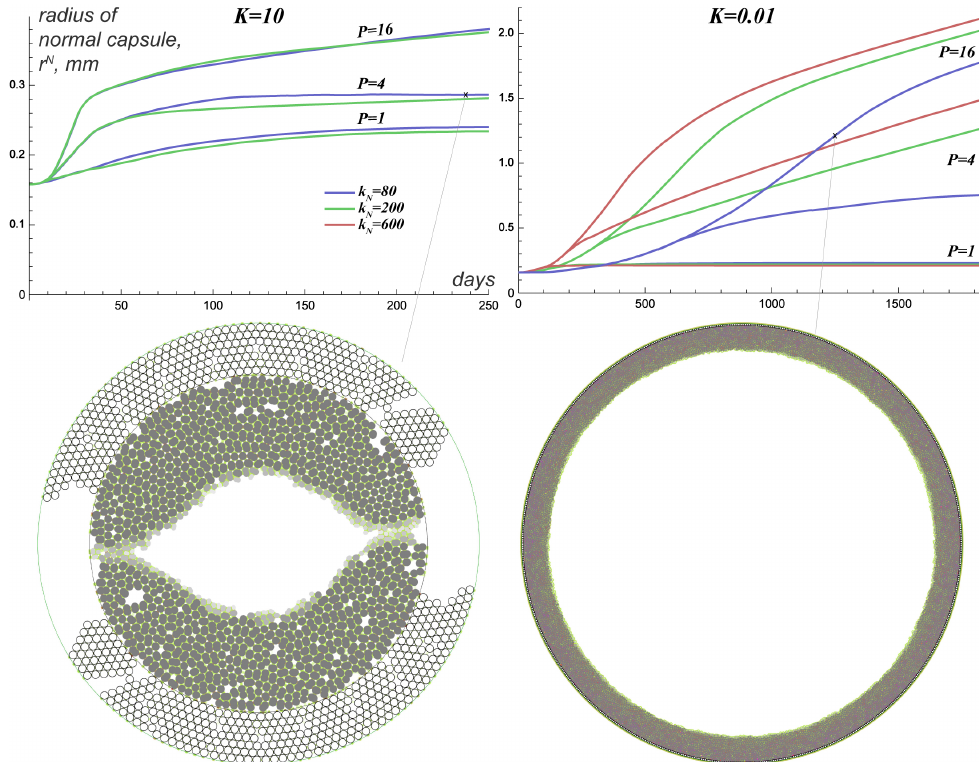
Figure 8. Top row: Dynamics of the radius of normal capsule r N during encapsulated tumor growth in the tissue under variation of normal cell stress function coefficient k N , tissue conductivity K , and coefficient of nutrient inflow P . Tumor cell stress function coefficient k T = 80, and other parameter values are from the basic set (see Tables 1 and 2). Bottom row: Snapshots of the simulations at the parameter values and times marked by crosses in the top row. The color of each cell corresponds to its radius, with lighter dying cells being smaller and thus closer to